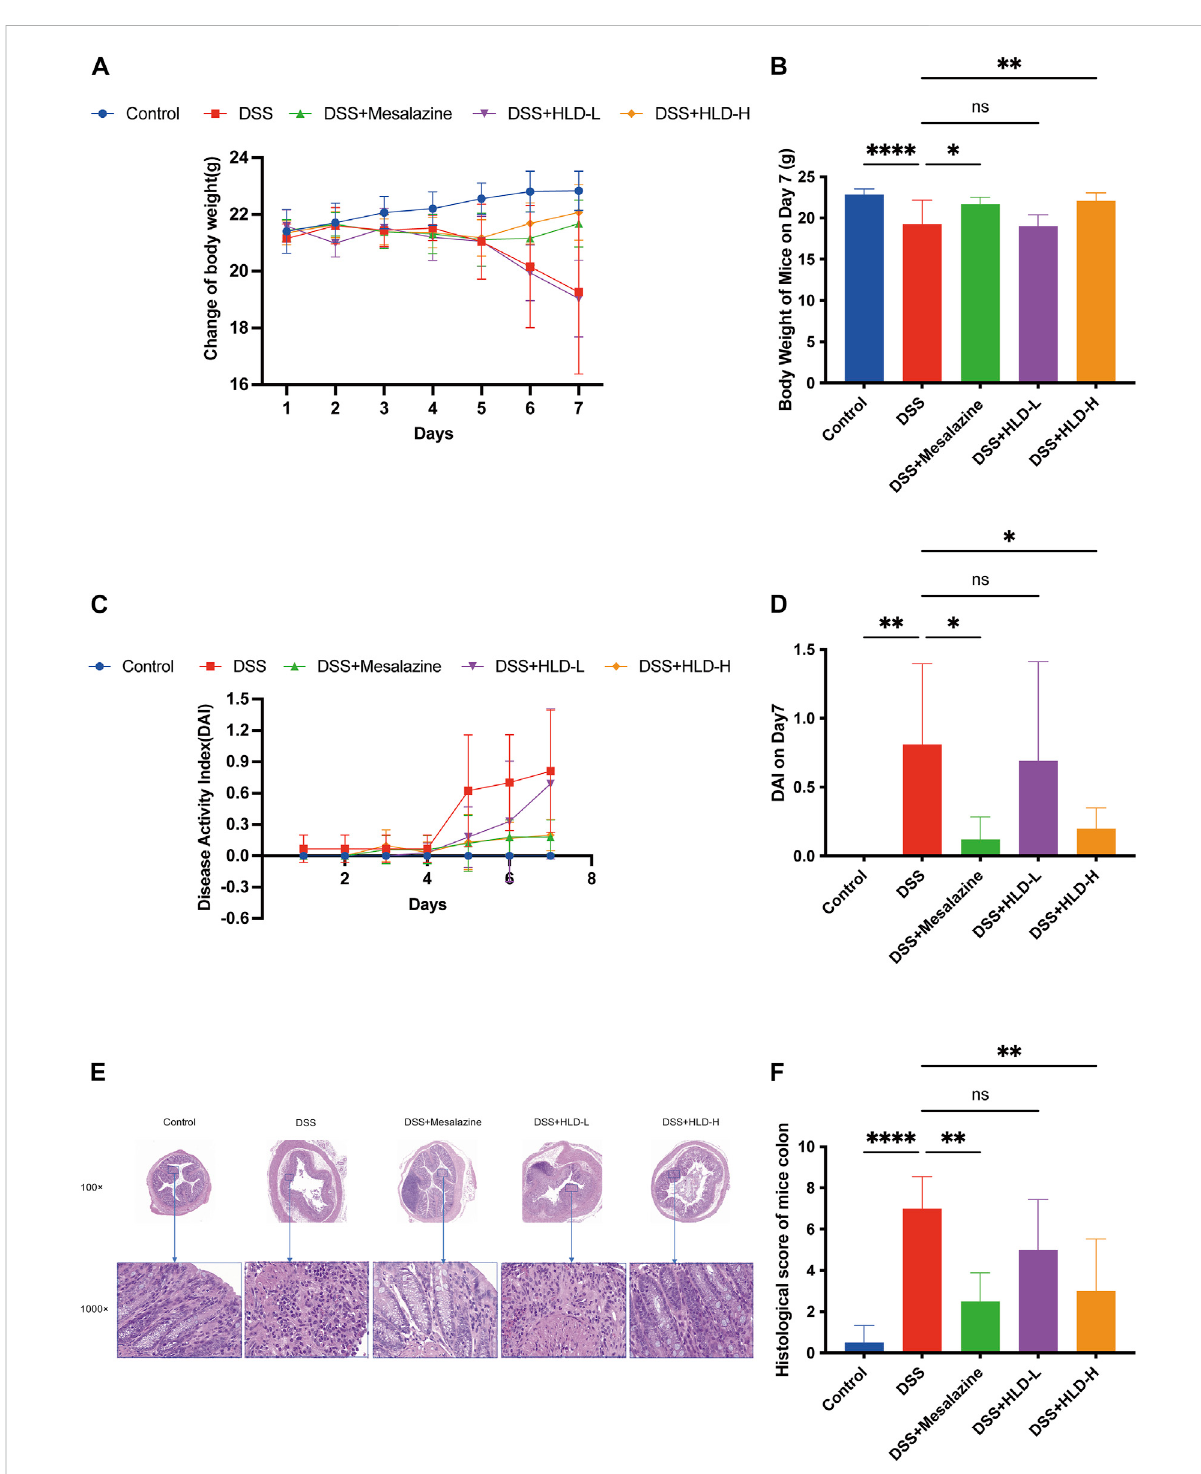
FIGURE 3 HLDimprovedDAIandalleviatedtheUCmice ’ spathology. (A , B) Thetrendofbodyweightchangesinmiceandacomparisonofbodyweighton day7werepresented. (C , D) ThetrendofDAIchangesinmiceandacomparisonofDAIonday7werepresented. (E , F) Thecomparisonofhematoxylin & eosin (HE) staining results and histological scores of mice colonic tissues. All data are expressed as the mean ± SD. ( n = 3). * p < 0.05, ** p < 0.01, **** p <